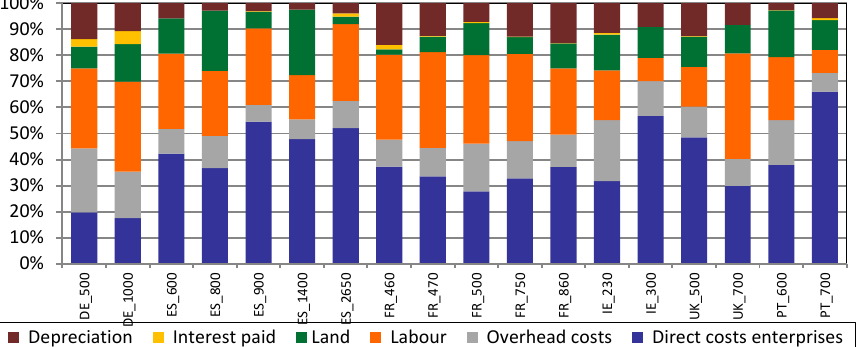
Figure 4. Whole farm costs considering the opportunity cost for land and labor in percentage. Source: model results.